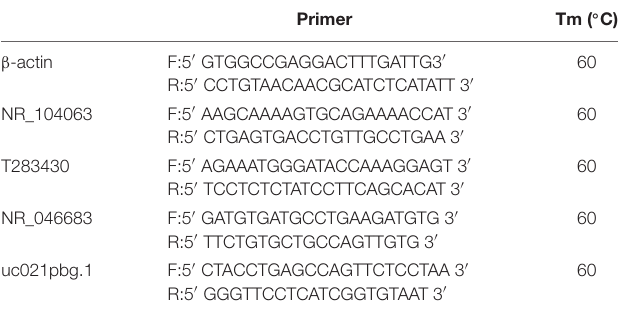
TABLE 2 | Primers designed for qRT-PCR validation of candidate lncRNAs. Primer